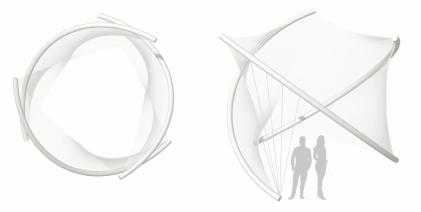
Figure 8: Artistic impression of the designed pavilion, top view and side view.